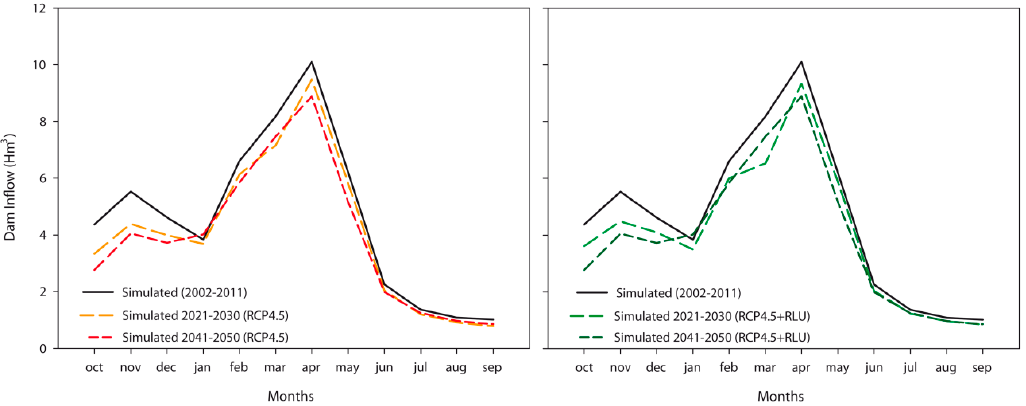
Figure 11. Mean seasonal dam inflow for simulated period for the current, short-term and mid-term future periods under climatic conditions ( left ) and under combined action of climatic and land-use change conditions ( right ).